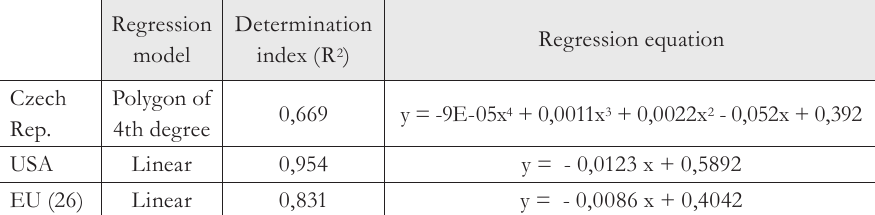
Tab. 9 - Results of regression analysis of the values of the time series of the researchers and terti- ary education graduates. Source: Eurostat, 2013a), (Eurostat, 2013b), own